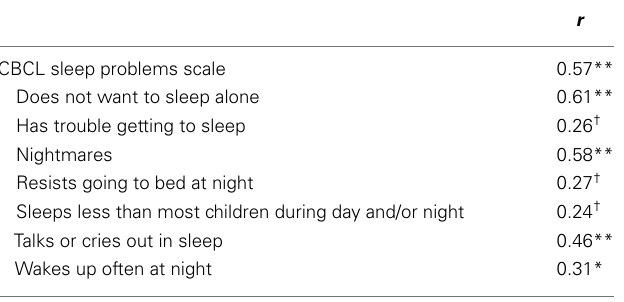
Table 2 | Spearman rank-order correlations between CBCL maternal and paternal scores